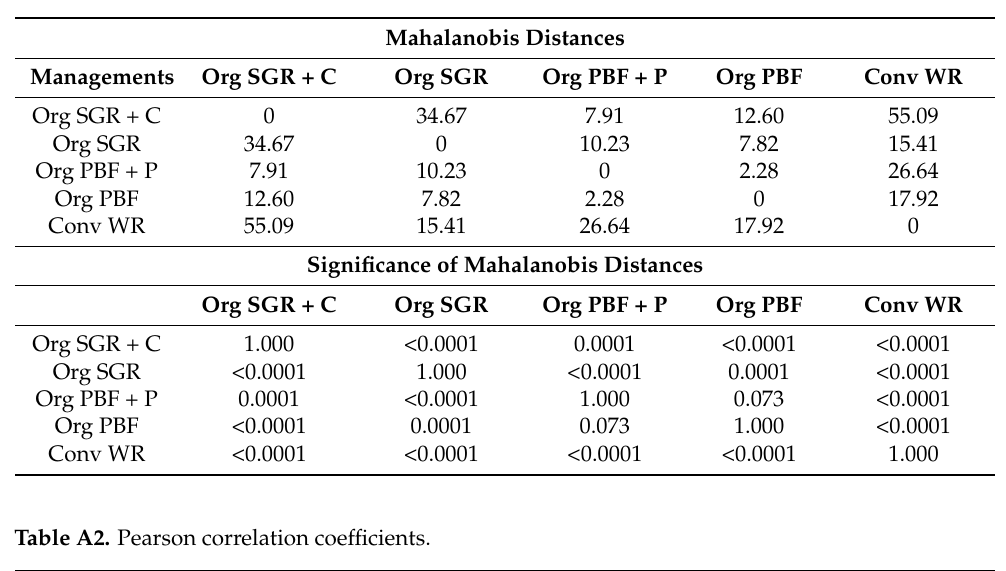
Table A1. Mahalanobis quadratic distances.